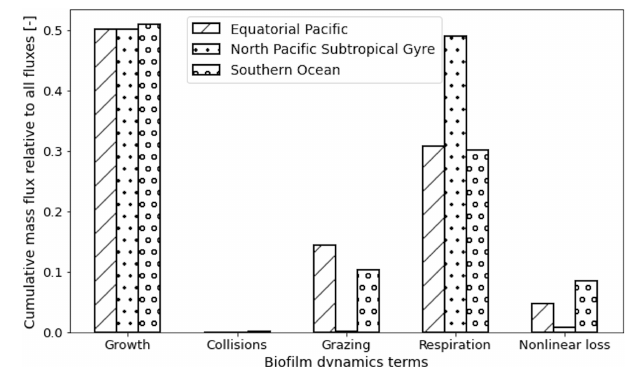
Figure 6. The overall relative cumulative mass flux of each of the five terms from Eq. (6) and Fig. 5 using all trajectories in the three regions of our study: (a) equatorial Pacific (forward slashes), (b) North Pacific Subtropical Gyre (dots) and (c) Southern Ocean